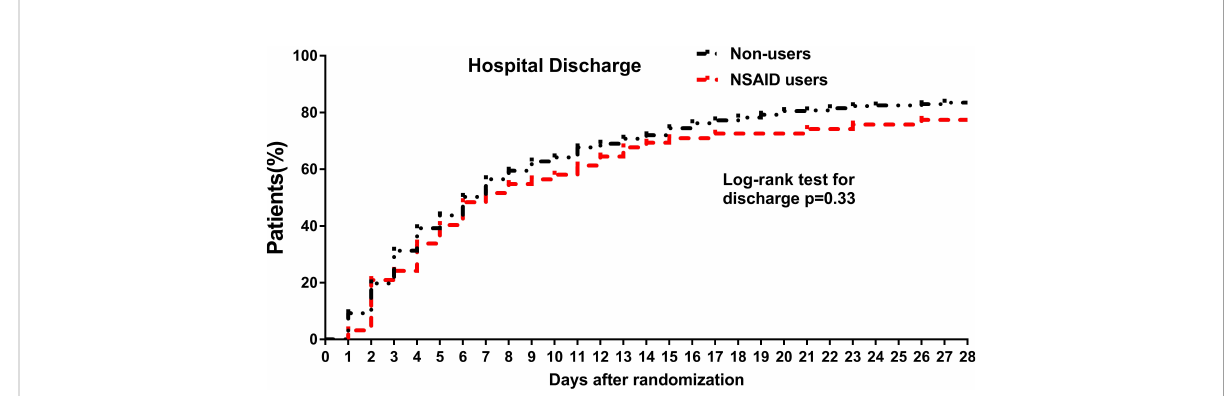
FIGURE 2 Cumulative incidence curves of hospital discharge through 28 days among NSAID users and non-users among hospitalized patients with COVID-19. For hospital discharge, all patients were followed up to discharge or 28 days after randomization in ORCHID. A patient was considered discharged from the hospital once discharged from the index hospitalization; rehospitalizations were not considered in this analysis. COVID-19, coronavirus disease 2019; ORCHID, Outcomes Related to COVID-19 Treated With Hydroxychloroquine Among Inpatients With Symptomatic Disease; NSAID, non-steroidal anti-in fl ammatory drug.